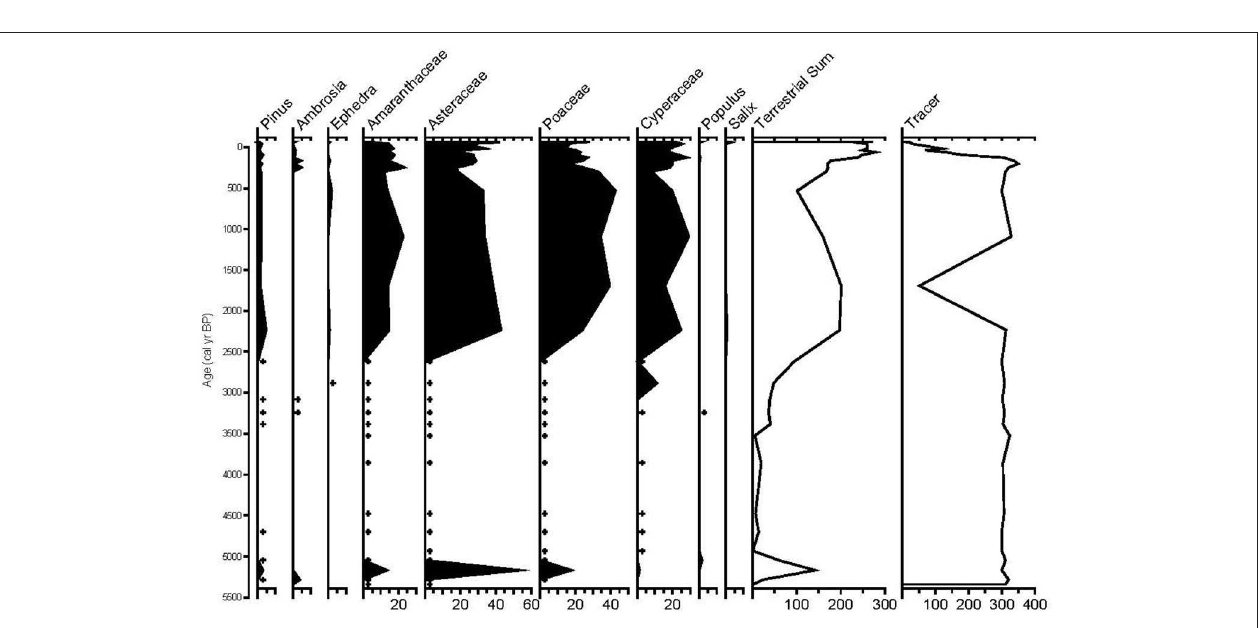
FIGURE 4 | Cloverdale pollen diagram. “ + ” symbol indicates counts of < 100 terrestrial grains. Counts < 100 are plotted as presence or absence to avoid over interpretation of sparse